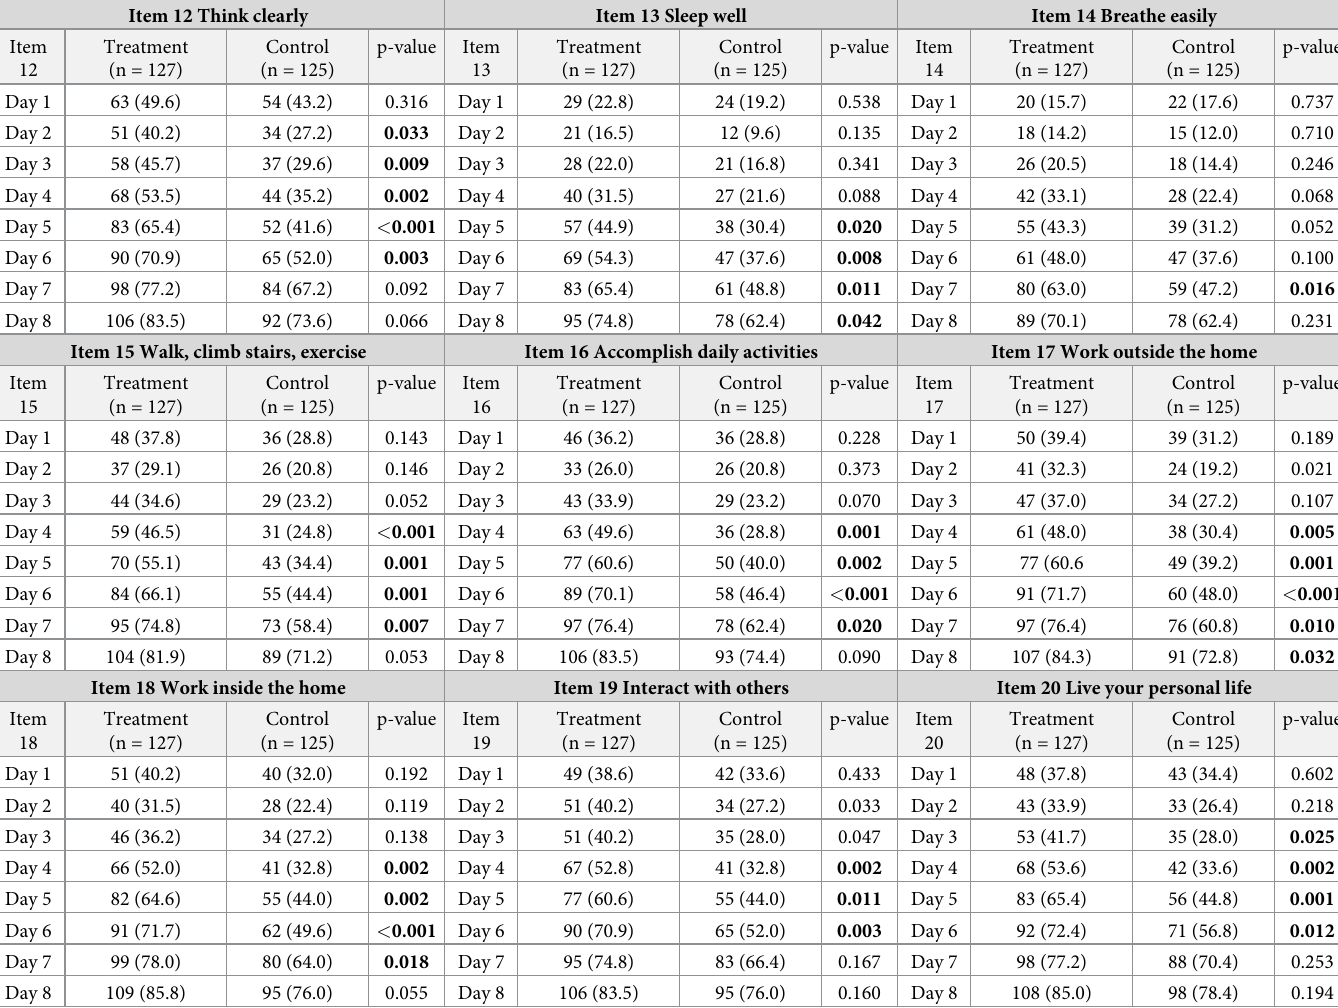
Table 3. Number of subjects (% of subjects in respective group) without symptoms for each individual item of the 9-item WURSS-21 QoL domain during the first 8 days of the common cold (evening